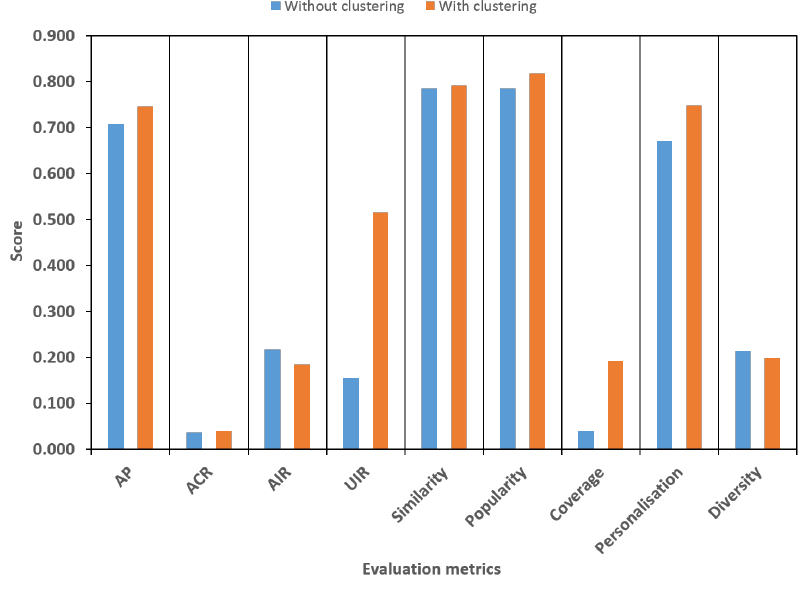
Figure 6. A bar plot of the average performance scores of the recommender system across the three experiments. Cases with and without clustering are shown in orange and blue,